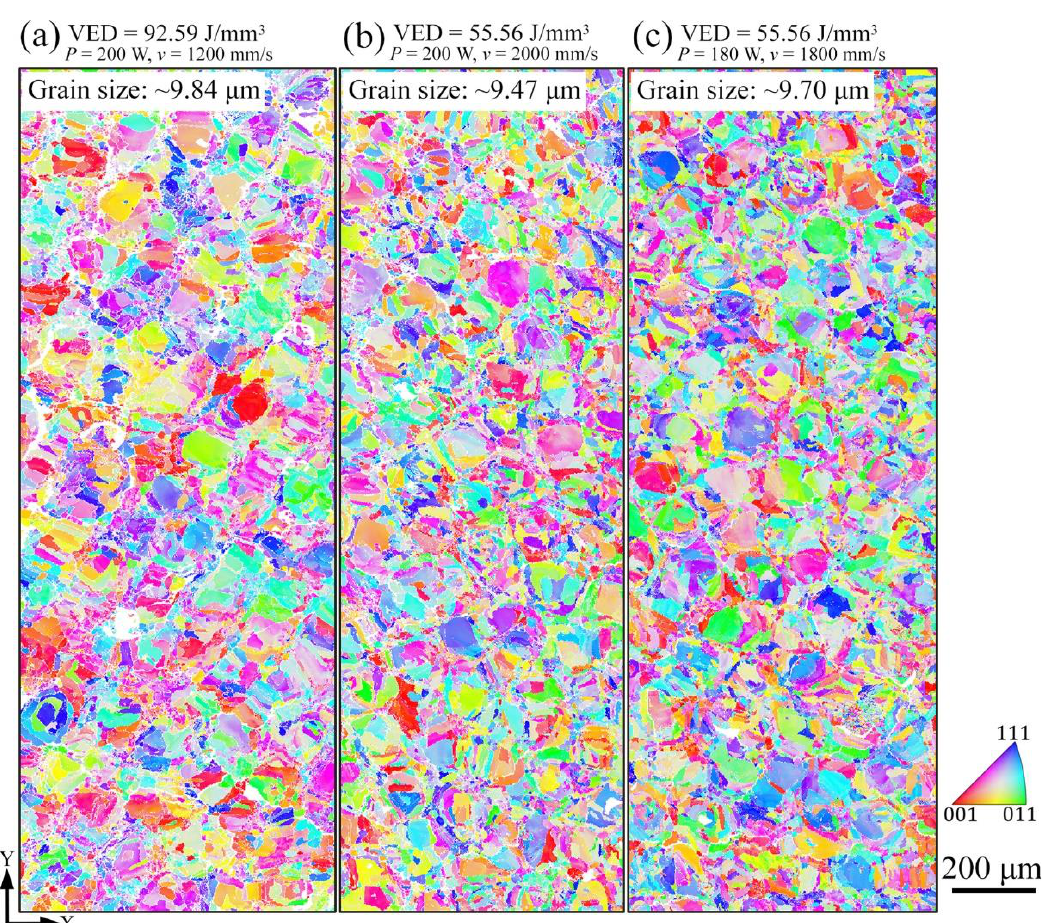
Figure 6. EBSD IPF maps on the xy-plane of AlCoCr 0.75 Cu 0.5 FeNi specimens produced by the different process parameters.